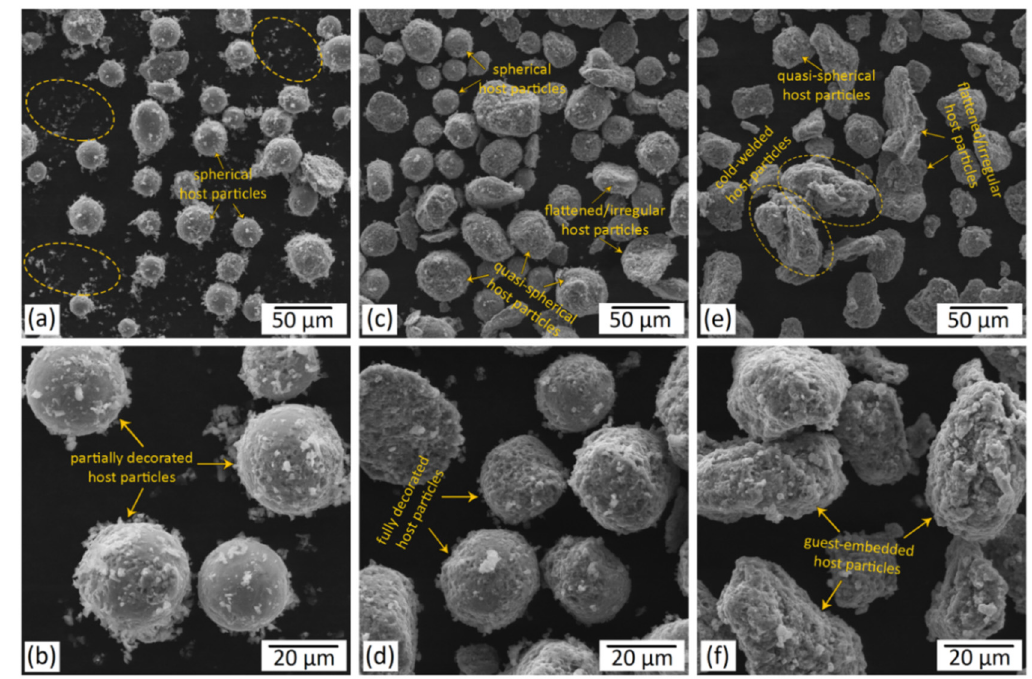
Figure 5. SEM micrographs of 5 wt.% B 4 C/Ti ‐ 6Al ‐ 4V mixed powder systems subjected to ball milling